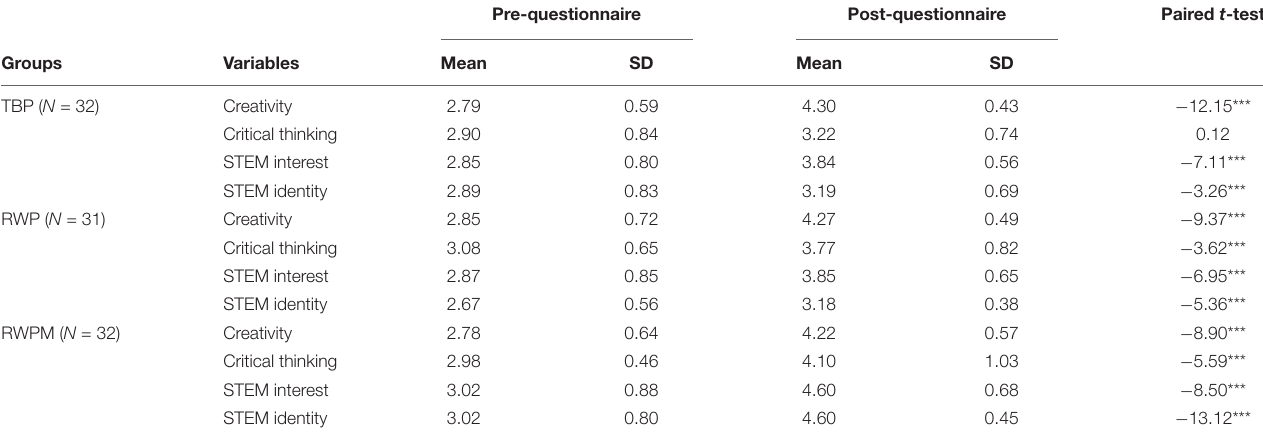
TABLE 3 | Descriptive statistics and paired t -test for pre- and